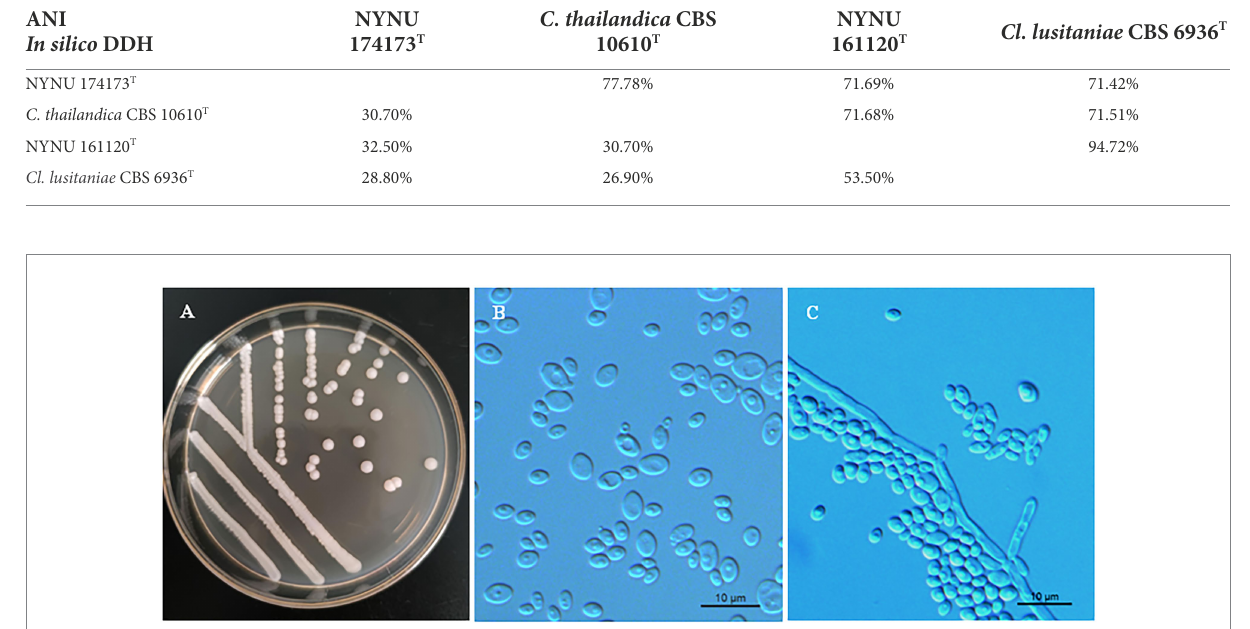
FIGURE 4 Morphological characteristics of Clavispora paralusitaniae sp. nov. (CICC 33276, holotype). (A) Colony morphology on YM agar after growth for 3 days at 25 ° C. (B) Budding cells after growth for 3 days in YM broth at 25 ° C. (C) Pseudohyphae with blastoconidia on CM agar after growth for 7 days at 25 ° C. Scale bars = 10 μ